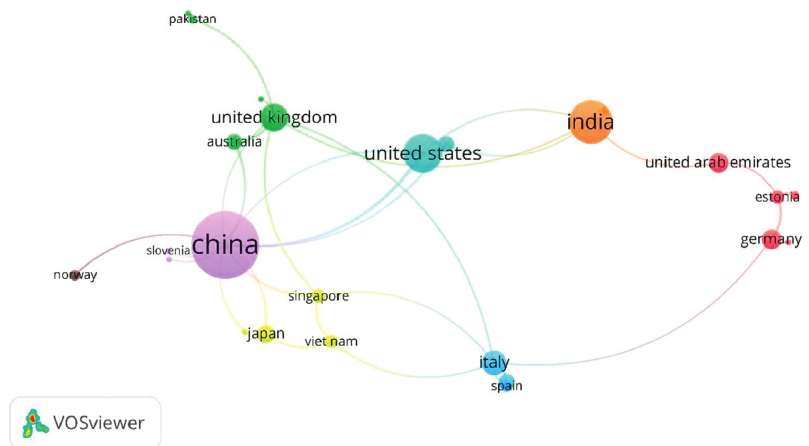
Figure 6: A network of cooperation between countries.